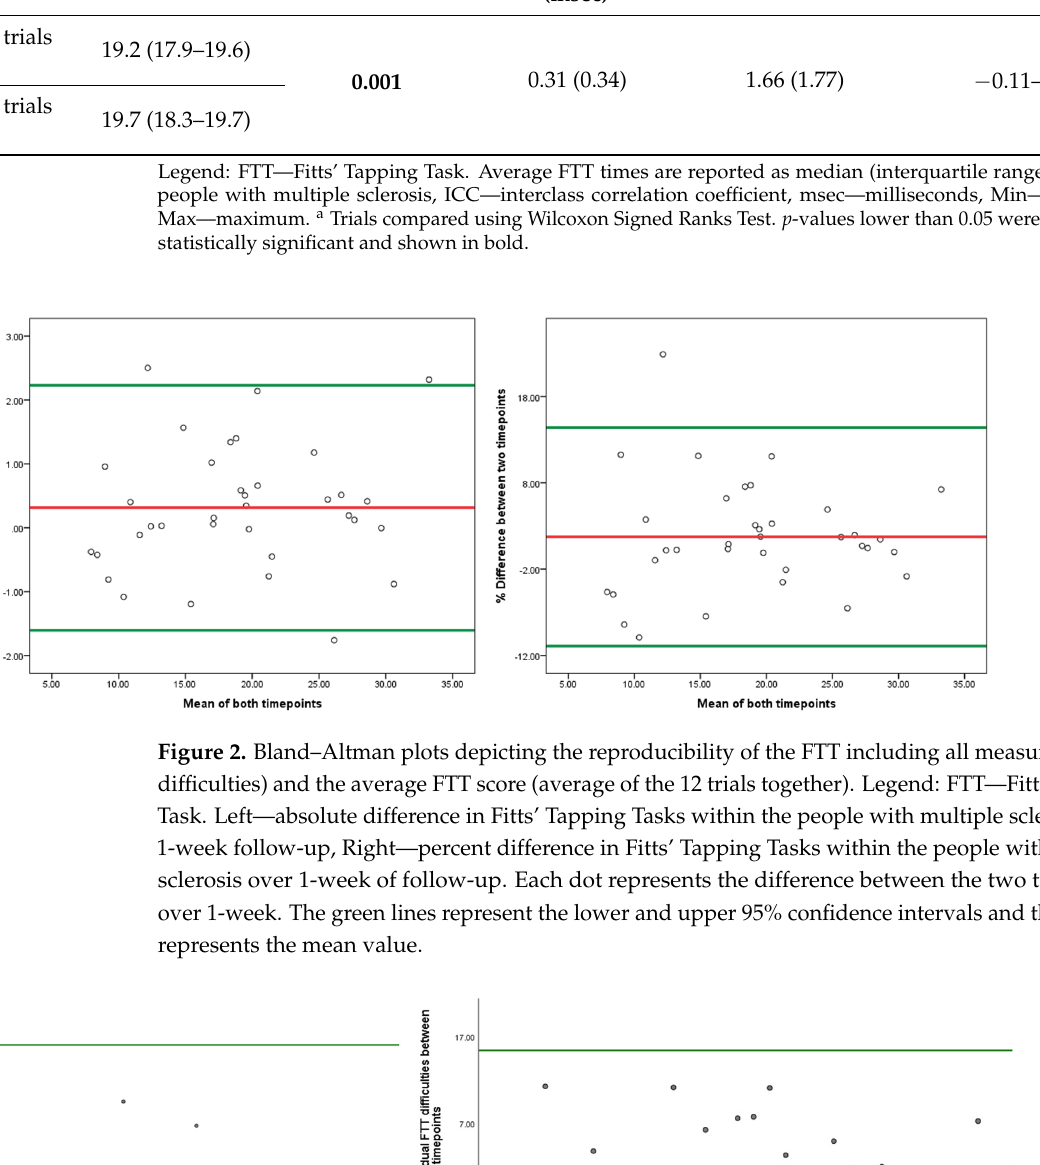
Table 3. Short-term reproducibility of Fitts’ Tapping Task in five pwMS over one week. Longitudinal FTT